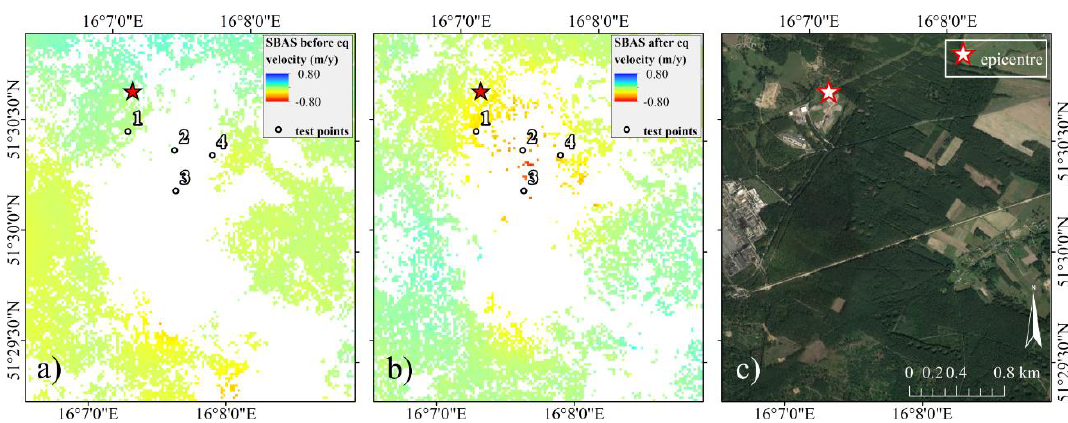
Figure 4. SBAS velocity pattern ( a ) before the event and ( b ) after the event; ( c ) land cover in the area of the subsidence (source: Google Earth).